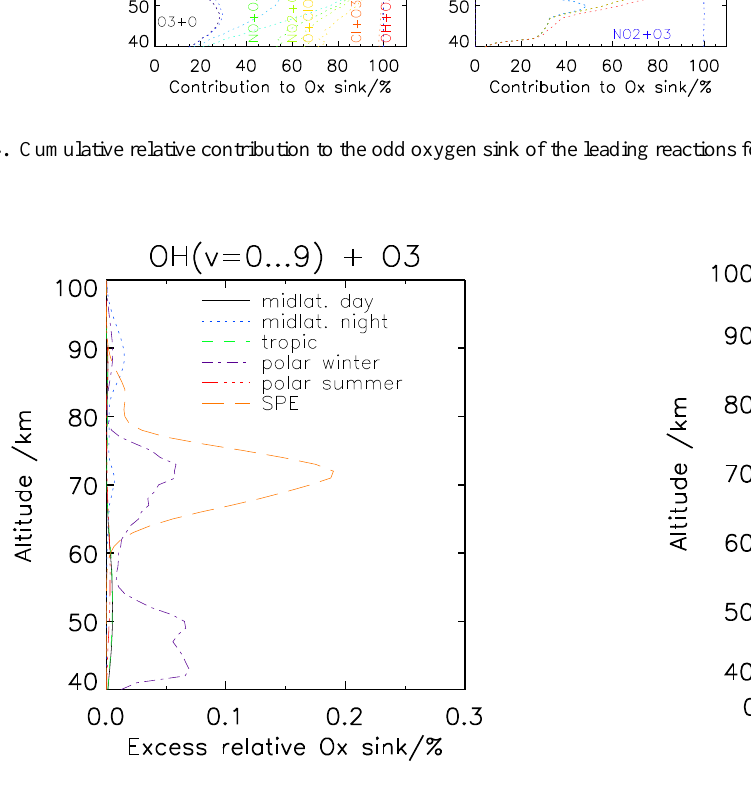
Fig. 5. Excess relative odd oxygen sink by consideration of vibra- tionally excited OH in the OH+O 3 reaction as a function of altitude for various atmospheres.